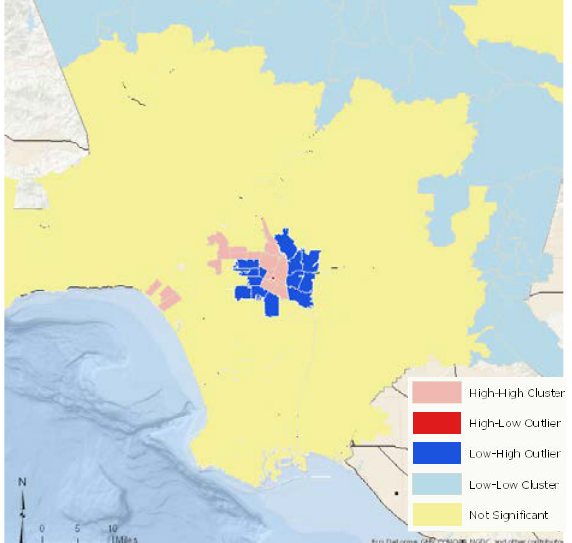
Figure 3. LISA Clusters of Airbnb Property Densities, 2015-17